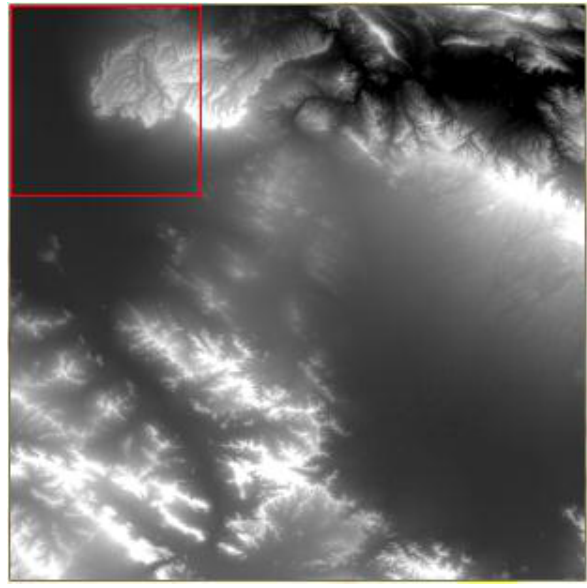
Figure 4. SRTM v4 DEM DATA (N34E049.demdata)